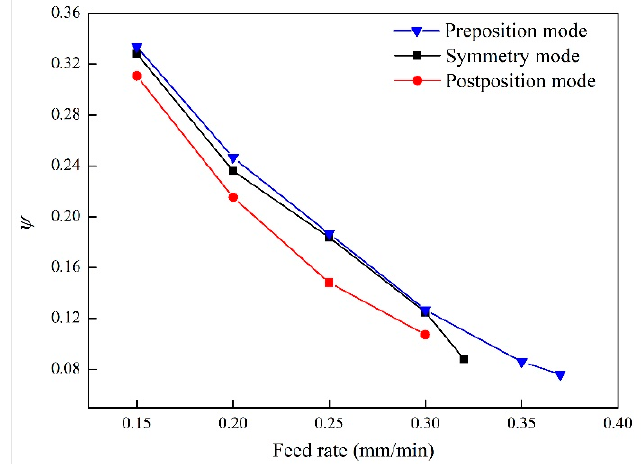
Figure 13. ψ vs. feed rate for the three coupling modes.